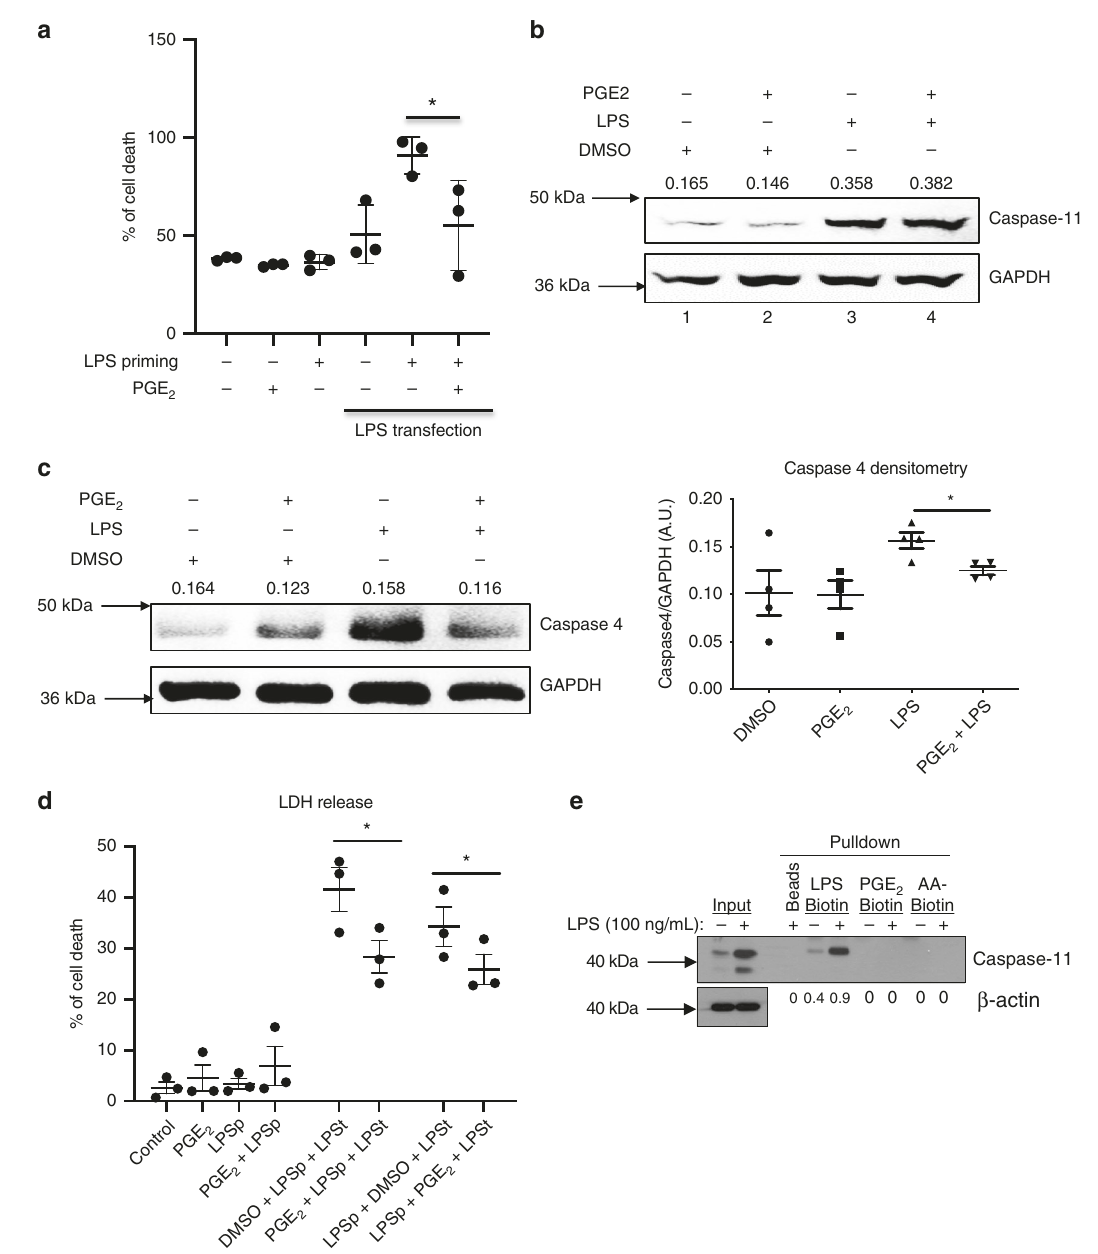
Fig. 3 Prostaglandin E2 inhibits capase-11-driven pyroptosis in LPS-primed cells. a Murine BMDMs were primed with 100 ng/ml of LPS for 4 h followed by stimulation with 1 μ M PGE 2 for 30 min; media was removed and followed by 2 μ g of LPS transfected using FuGENE 0.25% v/v liposomes overnight. Cell death was assessed by measuring LDH activity. The results shown are from a single experiment, with three mice in each group, and are representative of three independent experiments. Individual data points on the graph are means from technical duplicates. Ordinary one-way ANOVA with Tukey ’ s multiple comparison test has been used, * P < 0.01, error bars represent mean ± SD. b BMDMs were primed with 100 ng/ml of LPS for 4 h followed by stimulation with 1 μ M PGE 2 for 30 min, and lysates were assessed for caspase-11 expression by western blotting. The results shown are representative of three separate experiments. c Human monocyte-derived macrophages were treated with 1 μ M PGE 2 or DMSO for 30 min followed by 100 ng/ml LPS for 4 h. Lysates were assessed for caspase-4 expression by western blotting. The results shown are representative of three independent experiments, each utilizing one or two donors. Densitometry from all four donors is provided (* P < 0.01, two-tailed paired Student ’ s t test, error bars represent mean ± SEM). d Human monocyte-derived macrophages were treated with 1 μ M PGE 2 for 30 min before priming with 100 ng/ml of LPS for 4 h or for 30 min before transfection with 2 μ g/mL of LPS using FuGENE 0.25% v/v liposomes o/n. Supernatants were collected and analyzed for cell death using LDH assay. Data from three independent experiments are shown, each experiment utilizing cells from one donor. Individual data points on the graph are means from technical duplicates (* P < 0.01, two-tailed paired Student ’ s t test, error bars represent mean ± SEM). e Streptavidin pull-down assay. BMDMs were treated with 100 ng/ml of LPS for 4 h, lysed, precleared with strepatvidin beads and incubated with 2 μ g of biotinylated LPS, PGE 2 and arachidonic acid, and streptavidin beads for 1 h, and blotted for caspase-11. The results shown are representative of two separate